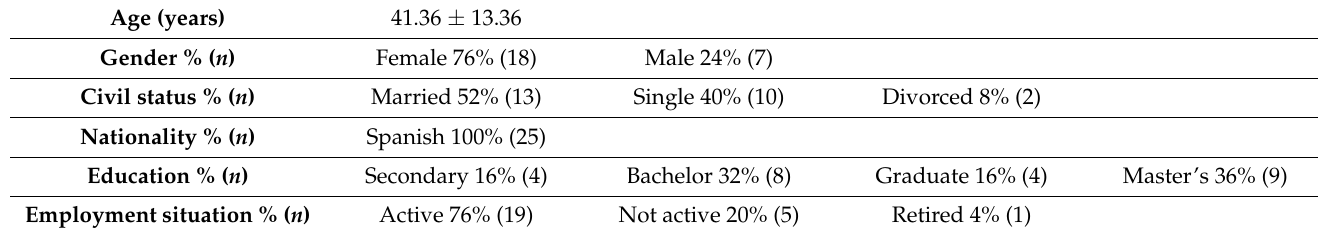
Table 1. Participants’ baseline